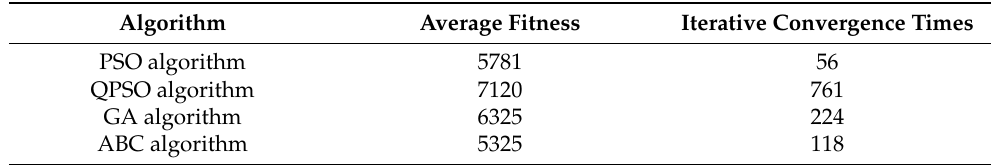
Table 8. Algorithm data comparison.